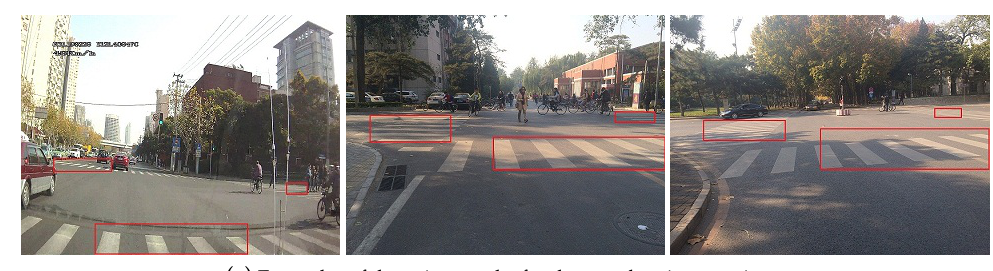
Figure 10. Examples of detection results with varying number of pedestrian crossings in the camera image.